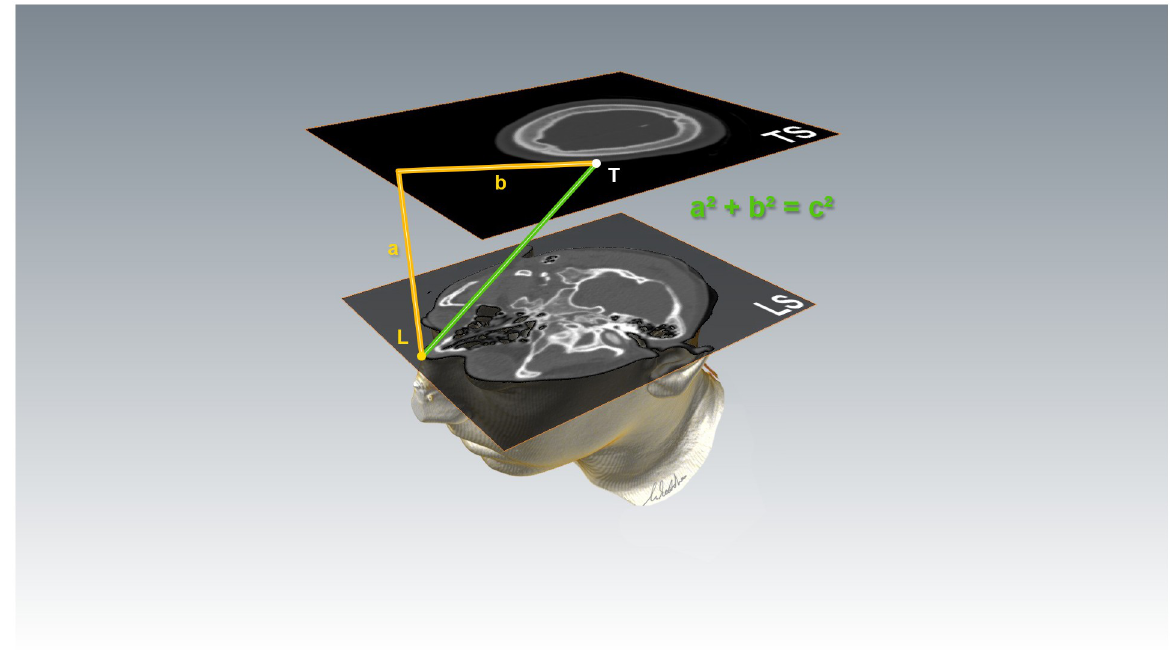
Fig 8. As long as the cursor position on the screen is not changed, the line a “travelled” by the cursor from landmark slice LS to target slice TS is vertical to the slice plane orientation. Hence, it is also vertical to the line b . The distance between L and T can therefore be calculated using Pythagoras’